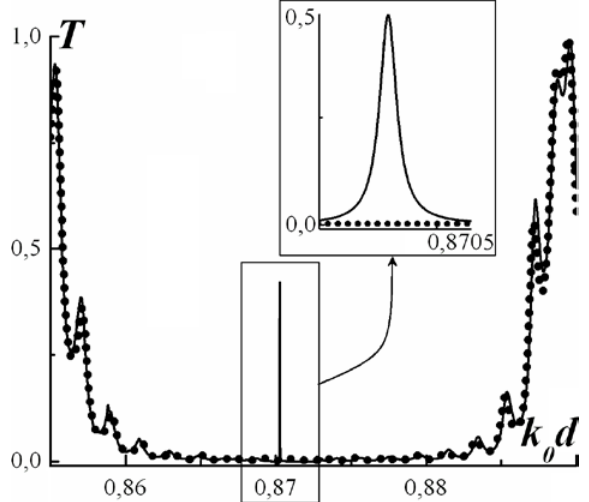
Figure 17. Propagation coefficient of the system under consideration. The dotted line corresponds to zero magnetization; the solid line corresponds to the magnetized